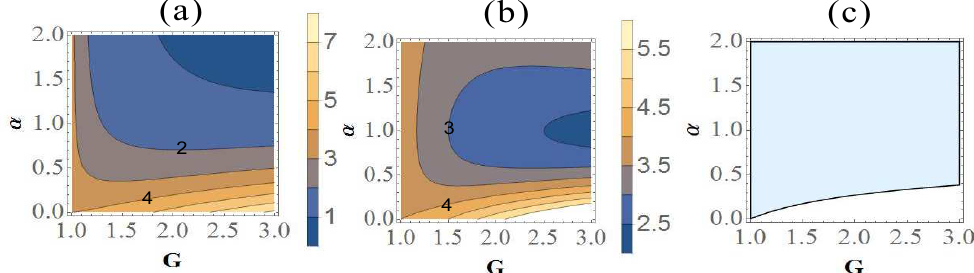
Figure 4. The contour plot of V s 1 ( a ) and V 12 ( b ); ( c ) the overlapped region between V s 1 < 4 and V 12 <